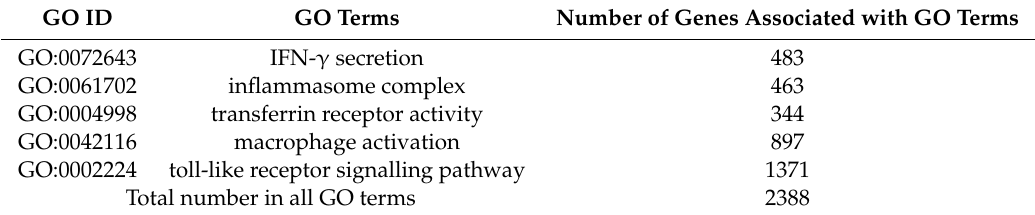
Table 1. Total number of GO Annotations for THE study of innate immune responses and tick-borne pathogens, whichmightbeplayingacriticalroleinTNFalphaandIL-4downregulationandMacrophage Activation Syndrome.